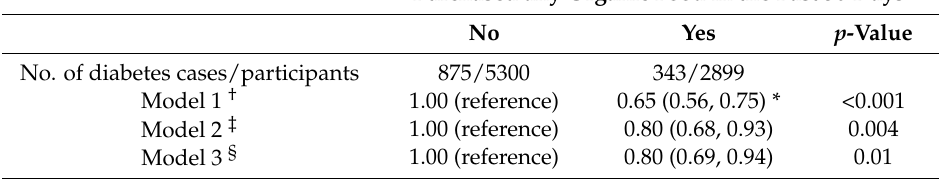
Association between organic food purchase and diabetes among 8199 participants, NHANES 2007–2010.